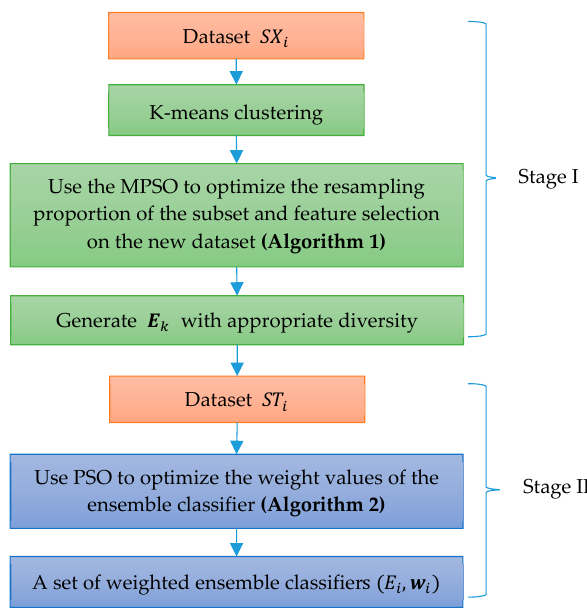
Figure 3. Implementation diagram of the WELAD.